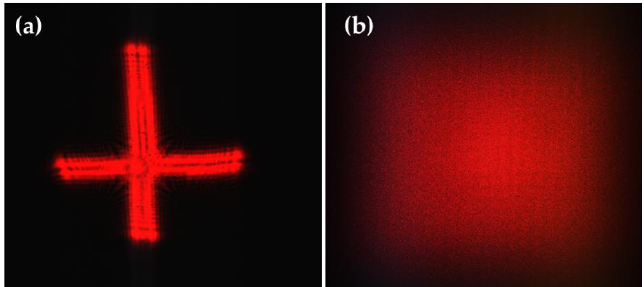
Figure 12. Beam homogenization with an arbitrary shape laser beam: ( a ) free-form incident laser beam; and ( b ) the reconstructed rectangular homogenization spot.